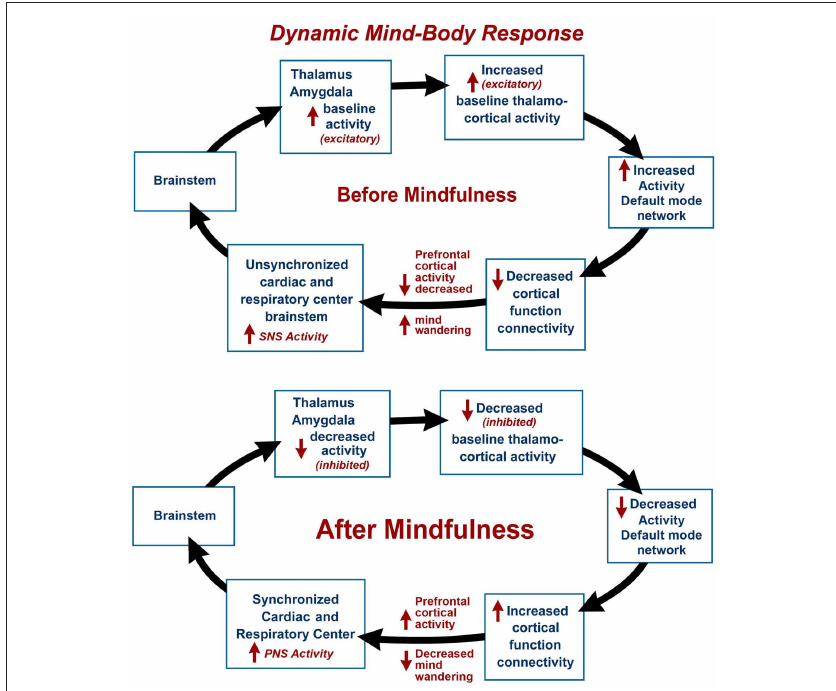
Figure 1 | The dynamic mind-body response is illustrated by a hypothetical psychophysiological condition before mindfulness meditation, with mind wandering and decreased prefrontal cortex activity, leading to unsynchronized cardiac and respiratory centers (elevated sympathetic nervous system activity) and increased activity of the thalamus and amygdala associated with baseline or increased activity of the Default Mode Network (DMN) and decreased cortical function connectivity. In the final stage and after meditation, there is decreased mind wandering and increased prefrontal cortex activity, leading to synchronized cardiac and respiratory centers (elevated parasympathetic nervous system activity) and decreased activity of the thalamus and amygdala associated with decreased DMN activity and increased cortical